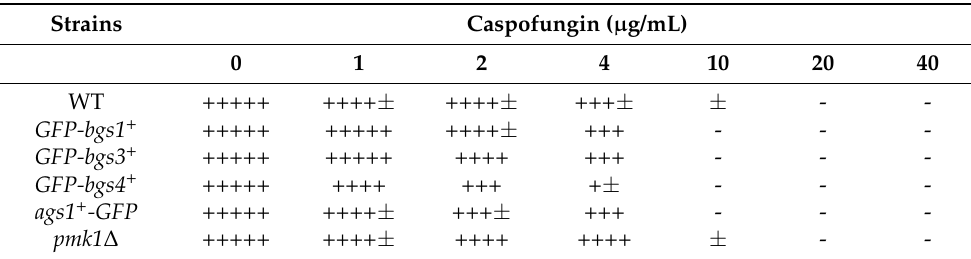
Table 1. In vivo susceptibility assay to caspofungin of S. pombe wild-type strains with the Bgs1, Bgs3, Bgs4, and Ags1 glucan synthases fused to GFP and strain lacking the Pmk1 kinase of the cell integrity